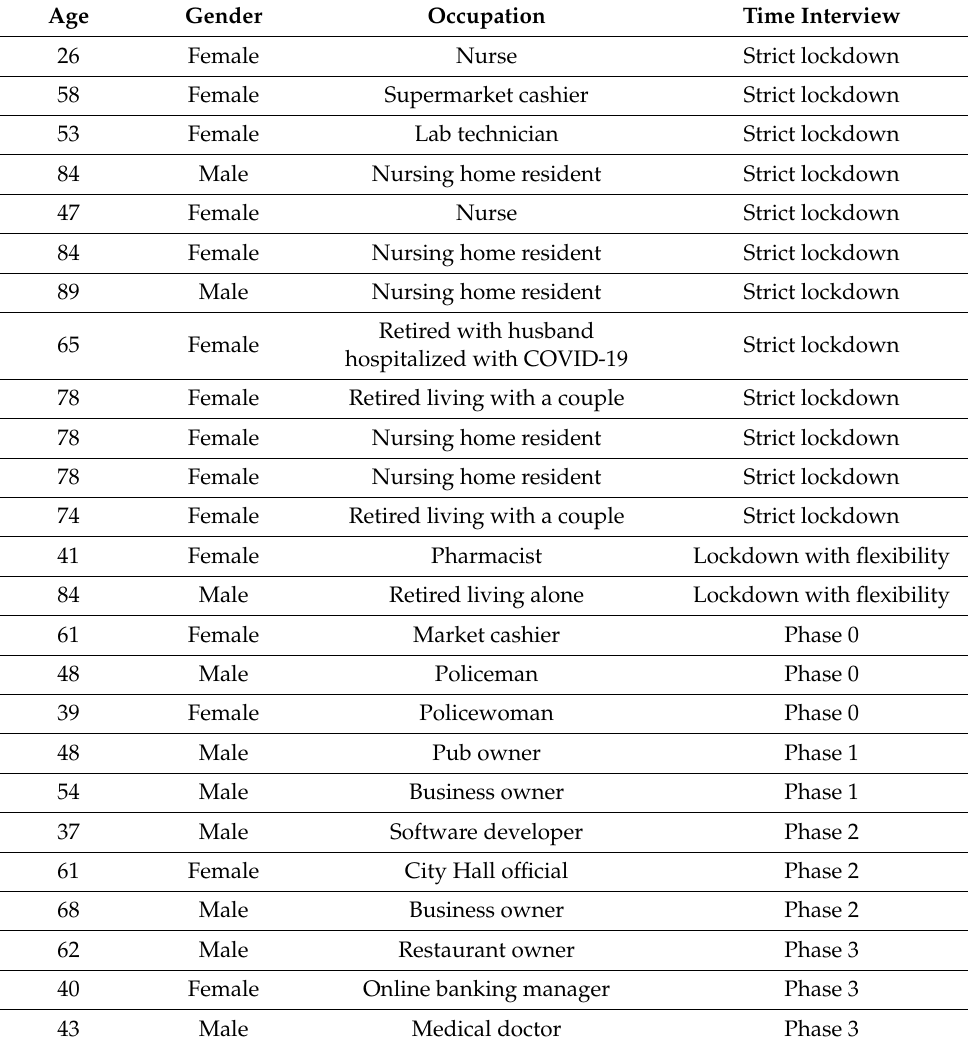
Table 1. Sample characteristics ( n =